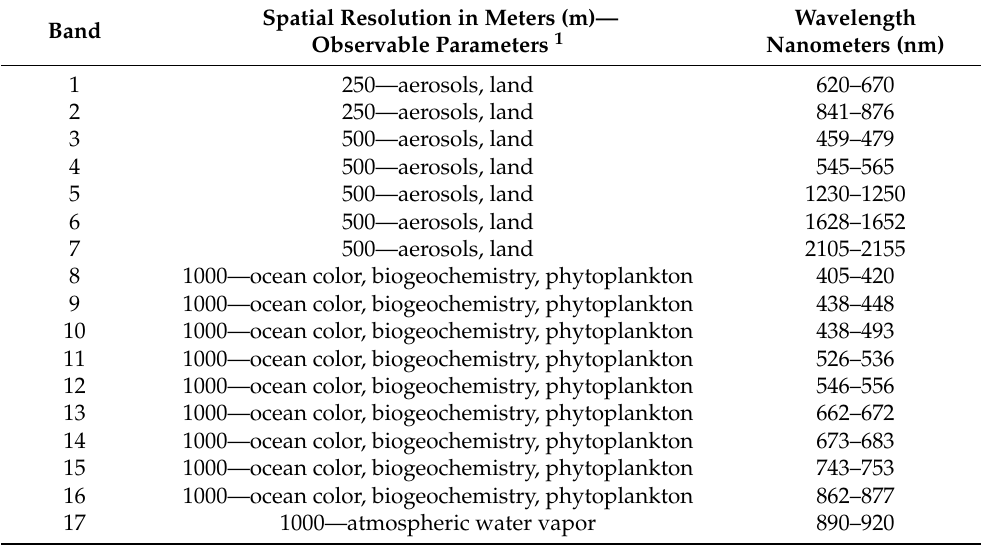
Table 3. Terra & Aqua MODIS Electromagnetic Spectrum Bands of